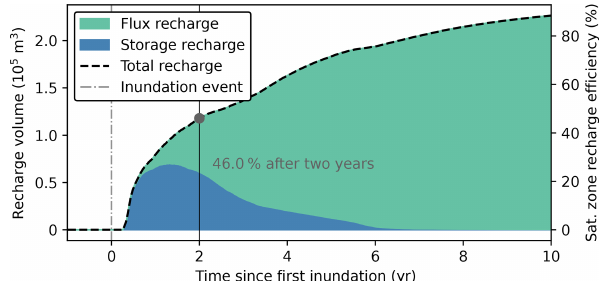
Figure 6. Temporal changes in the two components of saturated- zone recharge efficiency – storage recharge (blue) and flux recharge (green) – for a single simulation for 10 years following inundation. Flux recharge is cumulative over time, while storage recharge is transient. Thus, even after the water table returns to its pre-MAR level at ∼ 6 years, water content in the vadose zone remains higher than in simulations without recharge. As this water percolates to the saturated zone, it contributes to flux recharge. The recharge effi- ciency of this simulation is 46% after 2 years, which is higher than the median across all simulations